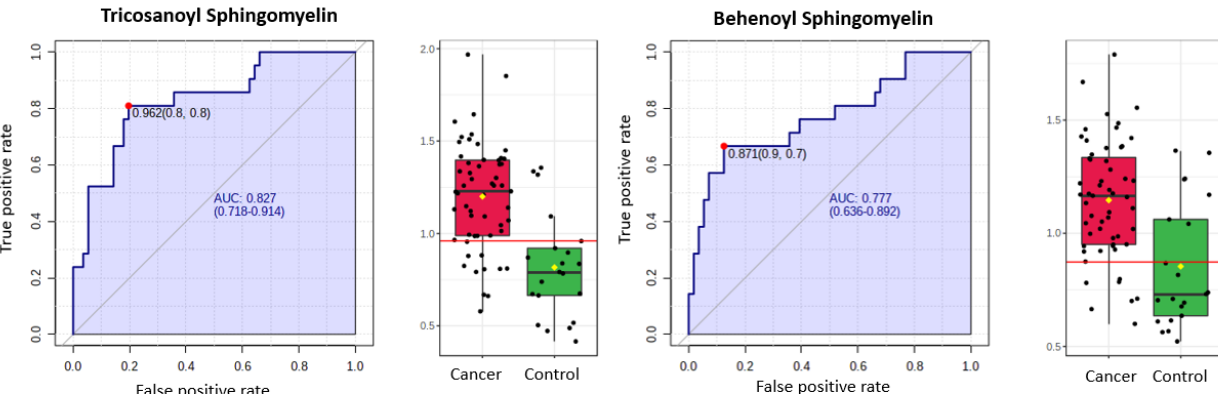
Figure 18. ROC and box-plot distributions of selected metabolites (sphingomyelins) for endometrial cancer detection in post-menopausal women ( n = 77, cases = 56, controls = 21) based on AUC analysis. The optimal cut-off was based on the closest to the top left corner principle and is indicated by the red dot in the ROC figures. The black dots in the box plots represent the concentrations of each metabolite, while the red diamond represents the mean concentration for the group. The notch represents 95% confidence interval around the median of each group.